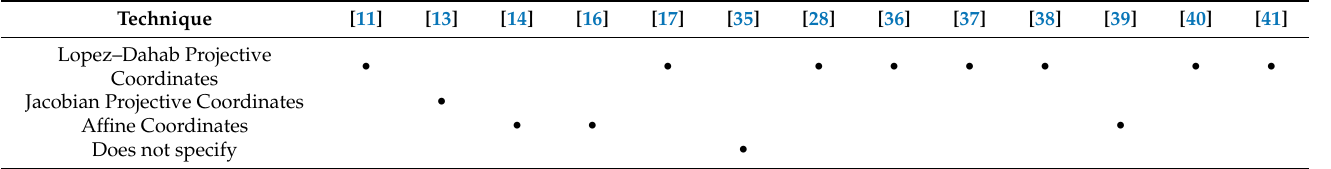
Table 7. Coordinates used in each ECC environment.